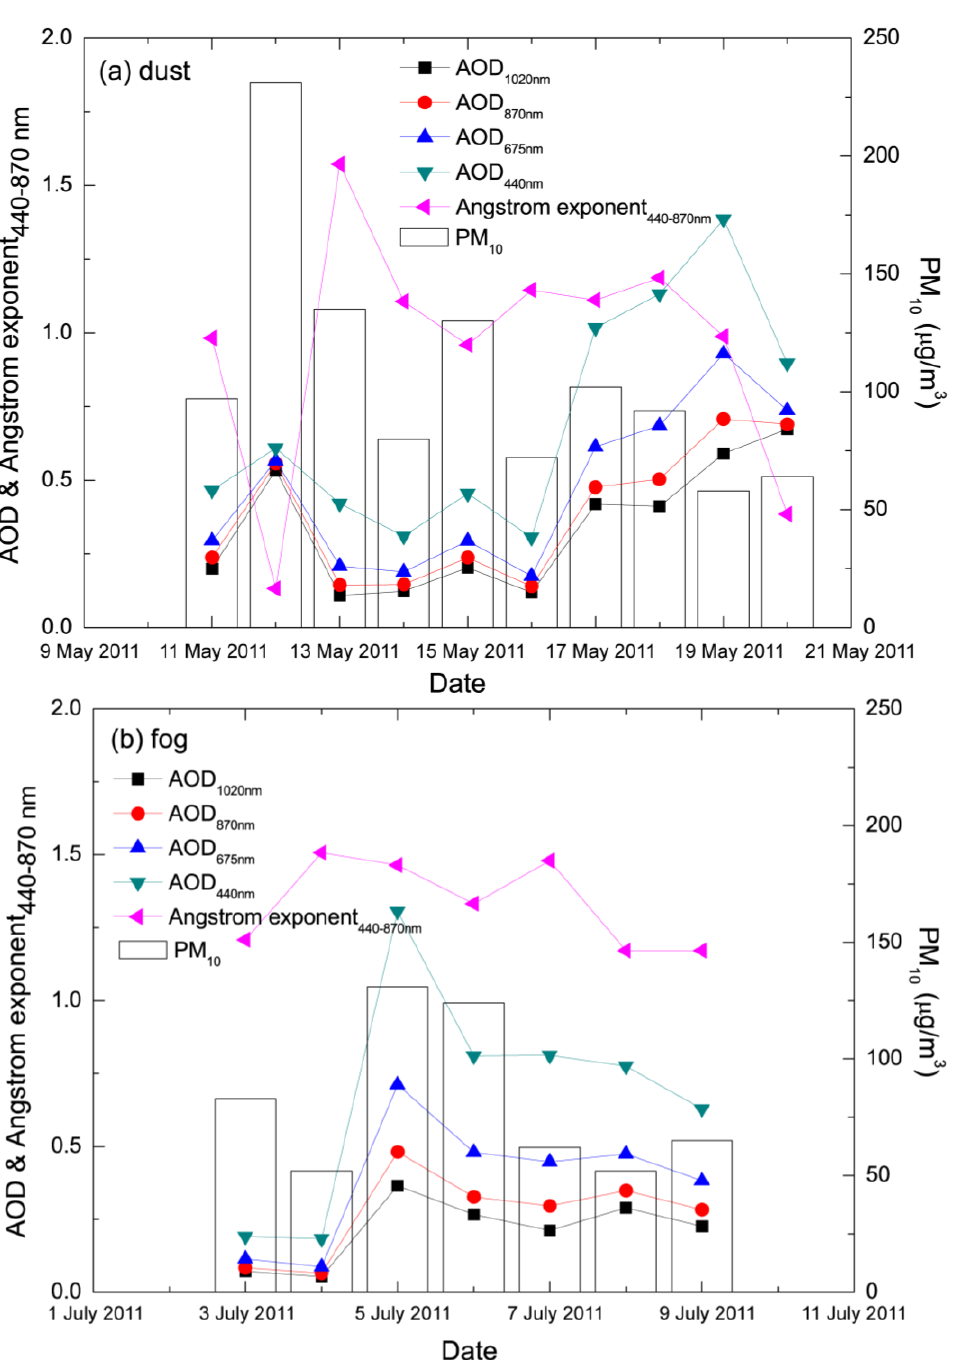
Figure 11 . Daily average values of AOD, Å ngström exponent and PM 10 at Dalian, China for ( a ) dust Figure 11. Daily average values of AOD, Ångström exponent and PM 10 at Dalian, China for ( a ) dust and ( b ) fog events and ( b ) fog